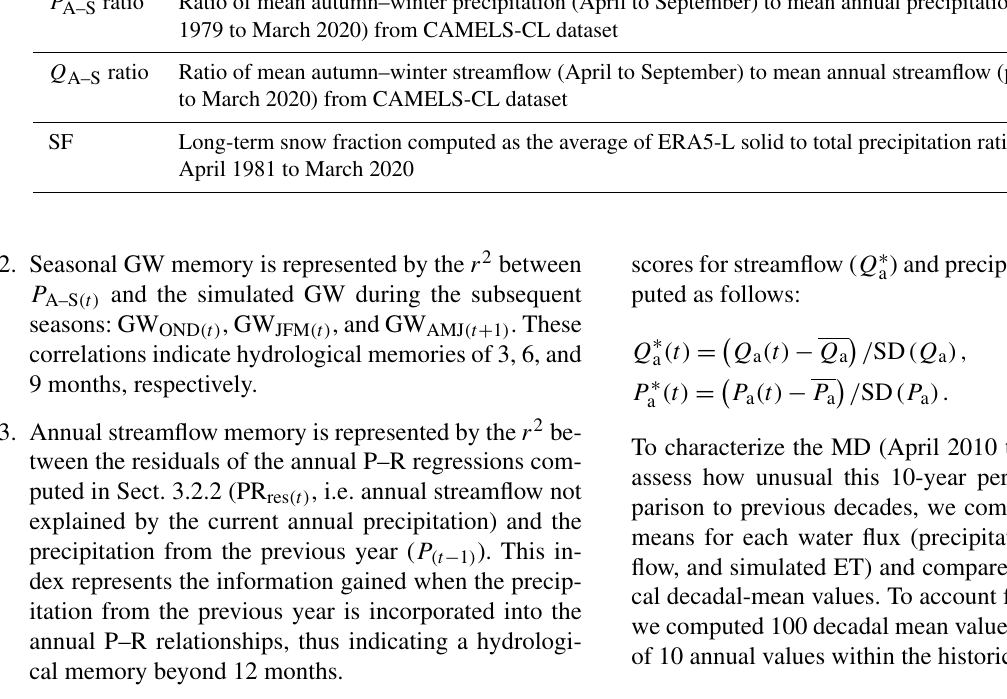
Table 1. Hydro-meteorological basin features used for classification.